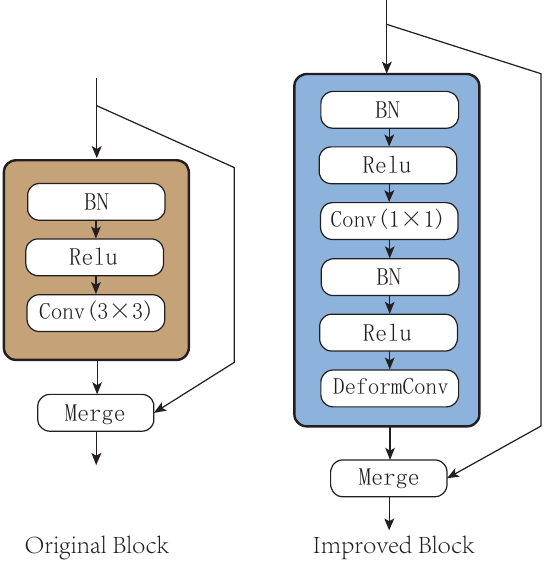
Figure 7. Improved structure of